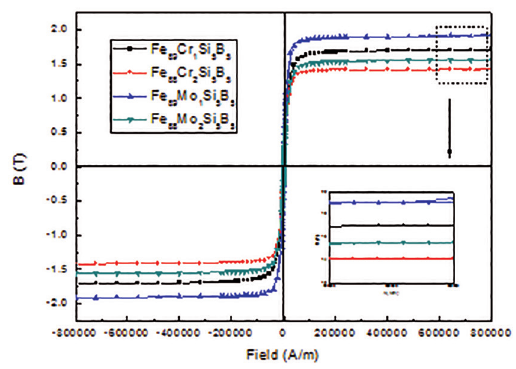
Si B M (M=Cr, Mo; x=1, 90-x 5 5 x ), coercivity ( H ), corrosion current density ( I s c